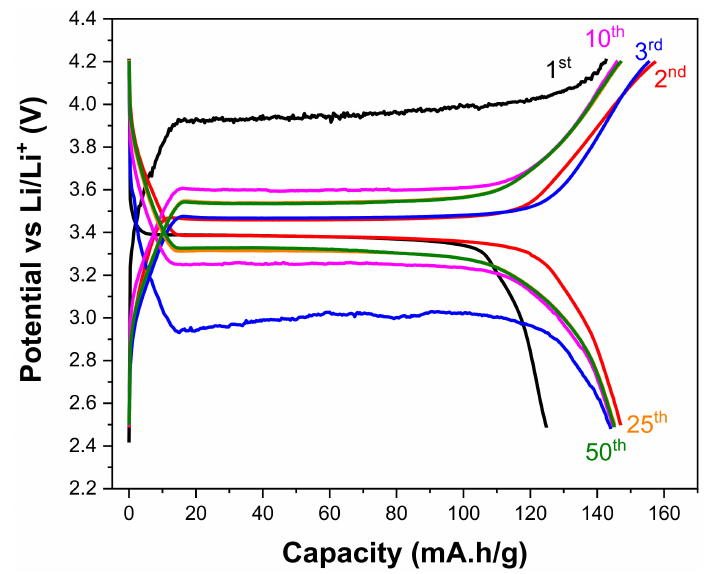
Figure 16. Cell voltage as a function of specific capacity obtained by charging and discharging at the same rate for the LiFePO 4 –PANI. The data were obtained by charging and discharging at 0.1 C.